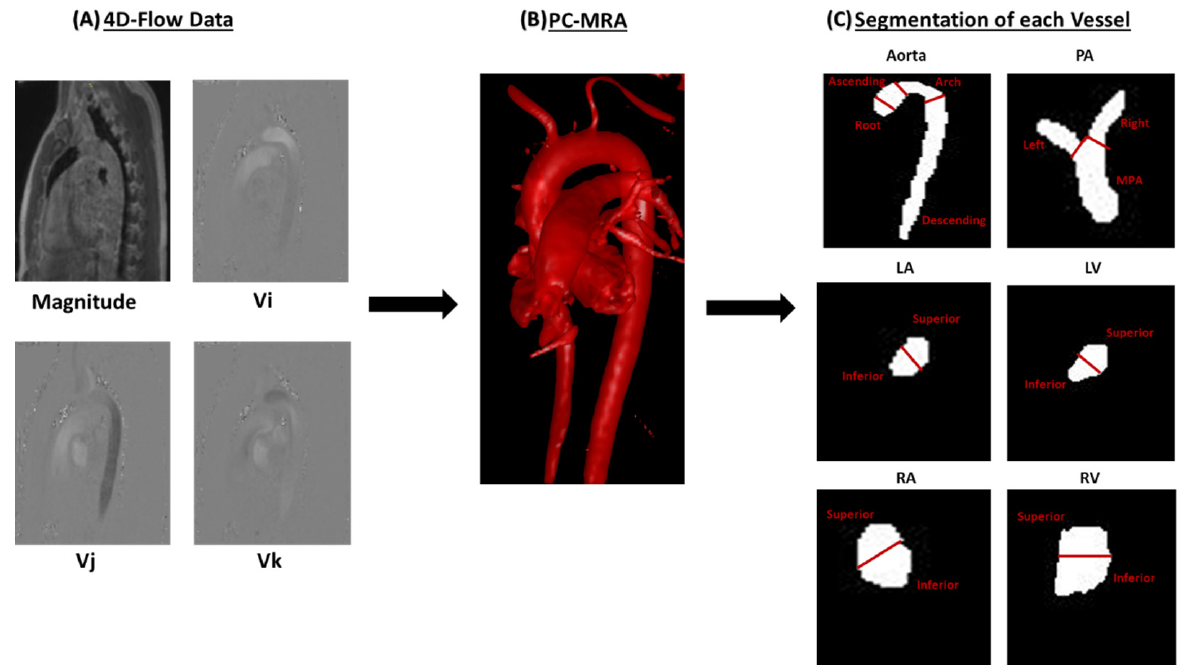
Figure 1. Postprocessing of 4D-flow data. First, 4D-flow velocity data in each direction (Vi, Vj, and Vk) were corrected for eddy currents, noise, and aliasing (Panel ( A )). Followed by correcting the data, a phase contrast-magnetic resonance angiogram (PC-MRA) was created (Panel ( B )) and was used to isolate the following vessels (Panel ( C )): Aorta, Pulmonary Artery (PA), Left Atria (LA), Left Ventricle (LV), Right Atria (RA), and Right Ventricle (RV). After segmentation, each vessel was subdivided into various sections. The Aorta is subdivided into the root, ascending, arch, and descending. The PA is divided into the left pulmonary artery, right pulmonary artery, and main pulmonary artery (MPA). The LA, LV, RA, and RV are all divided in the same way, splitting it into its superior and inferior components. After segmentation, an in-house Matlab tool “YYC 4D Flow TKE Tool” was used to Figure 2. The magnitude of the individual velocity-encoding directions was reconstructed